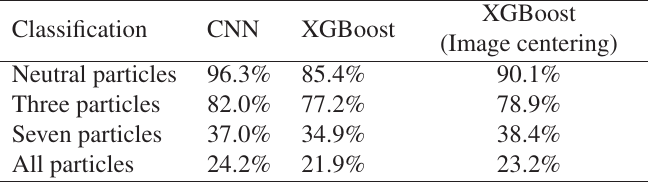
Table 6. Accuracy comparison between CNNs and